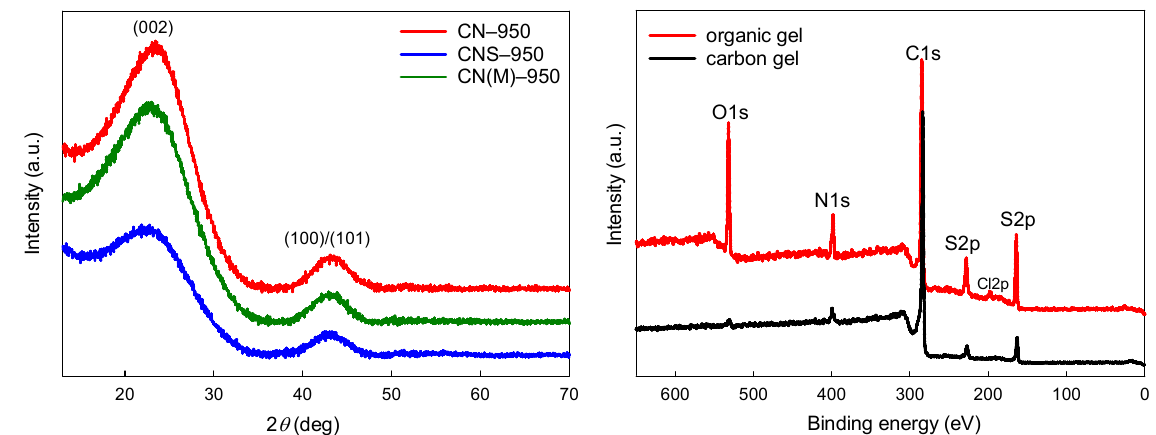
Figure 5. XRD patterns of carbonaceous materials obtained from the porous polymers after pyrolysis at 950 °C. XPS survey spectra of organic and corresponding carbon gels (pyrolysis at 750 °C) obtained from 2-thiazolecarboxaldehyde.